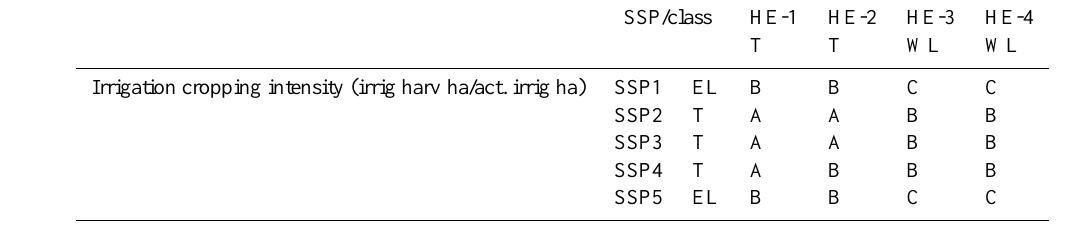
Table A7. Water dimension – irrigation cropping intensity